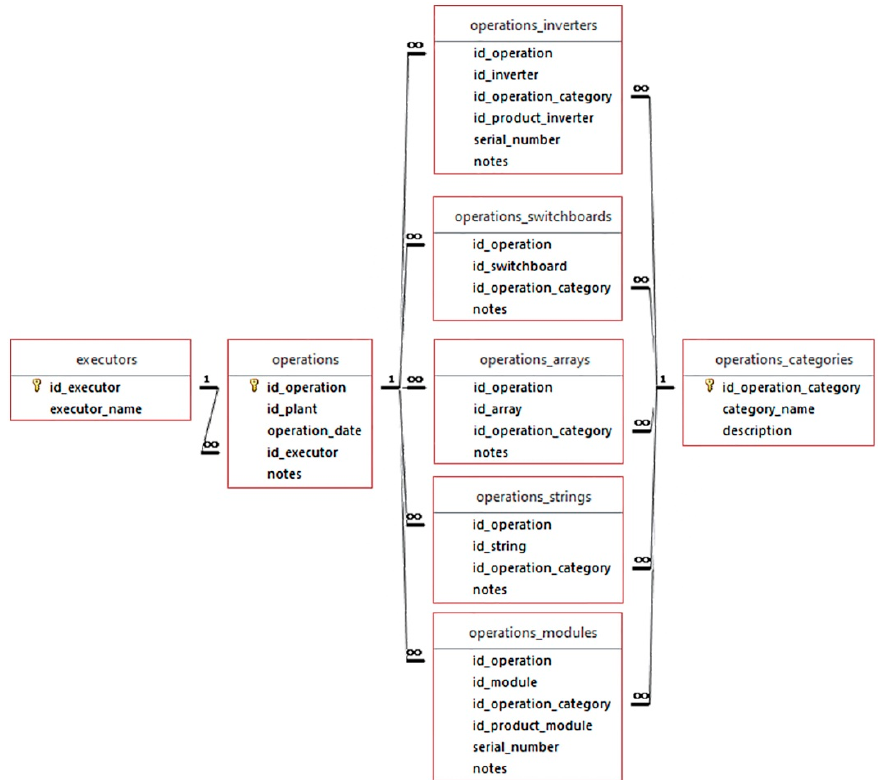
Figure 9. The operations group of the conceptual model implemented into the relational database.